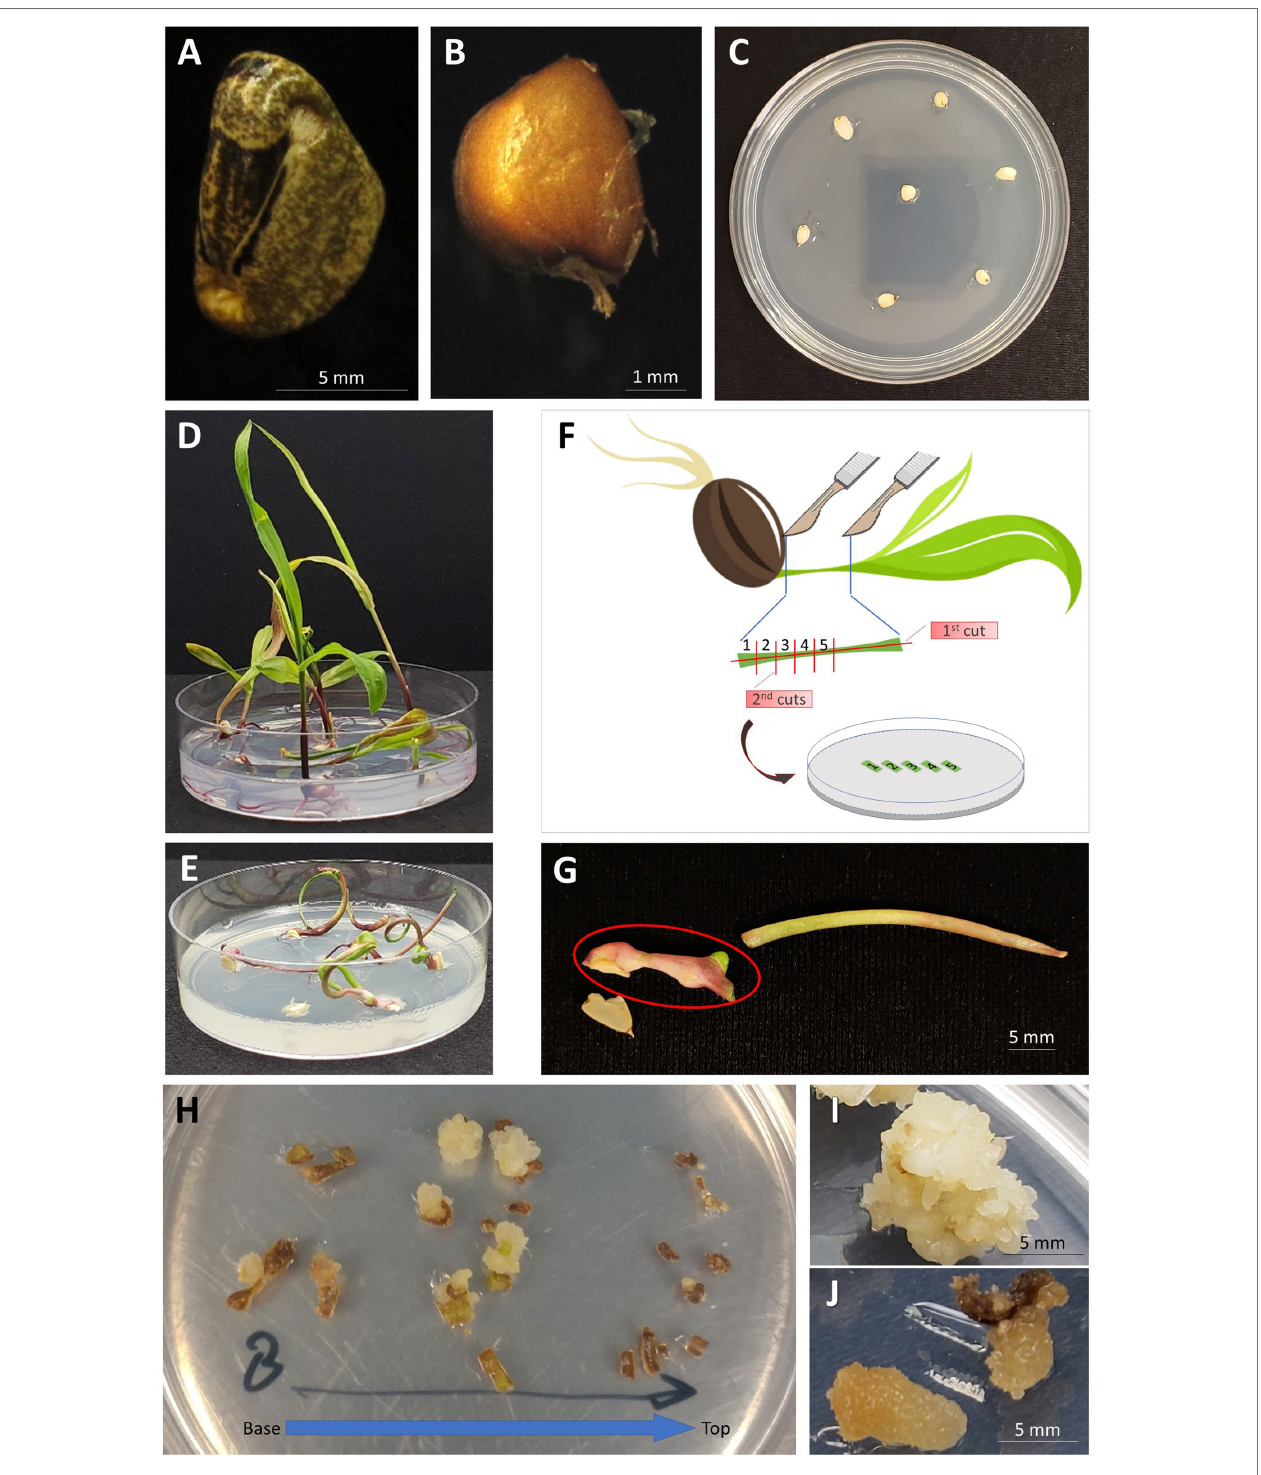
FIGURE 1 | Generation of embryogenic callus from the leaf tissue of teosinte seedlings. (A) A teosinte seed with the hard casing intact; (B) A “naked” seed with the casing removed; (C) Naked teosinte seeds placed on growth medium for germination; (D) Germination of teosinte seeds on ½ MS growth medium (14 days after sowing); (E) Germination of teosinte seeds on MSVS34-P2.2 growth medium (14 days after sowing); (F) Illustration of cutting the leaf segment and placement on callus induction growth medium; (G) Whorl segment explant (indicated by red circle) collected from seedling germinated on MSVS34-P2.2 medium; (H) Callus forming from leaf pieces of plant grown on MSVS34-P2.2 (14 days after callus induction). Leaf pieces are oriented from the base of the plant to the top; (I) Embryogenic callus capable of regeneration into a full plant (30 days after callus induction); (J) Non-embryogenic callus that will not regenerate into teosinte plants (30 days after callus